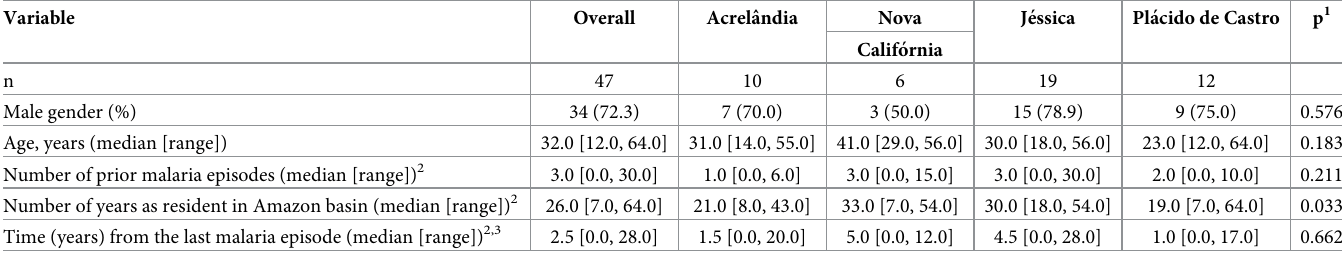
Table 1. Baseline characteristics of participants by study